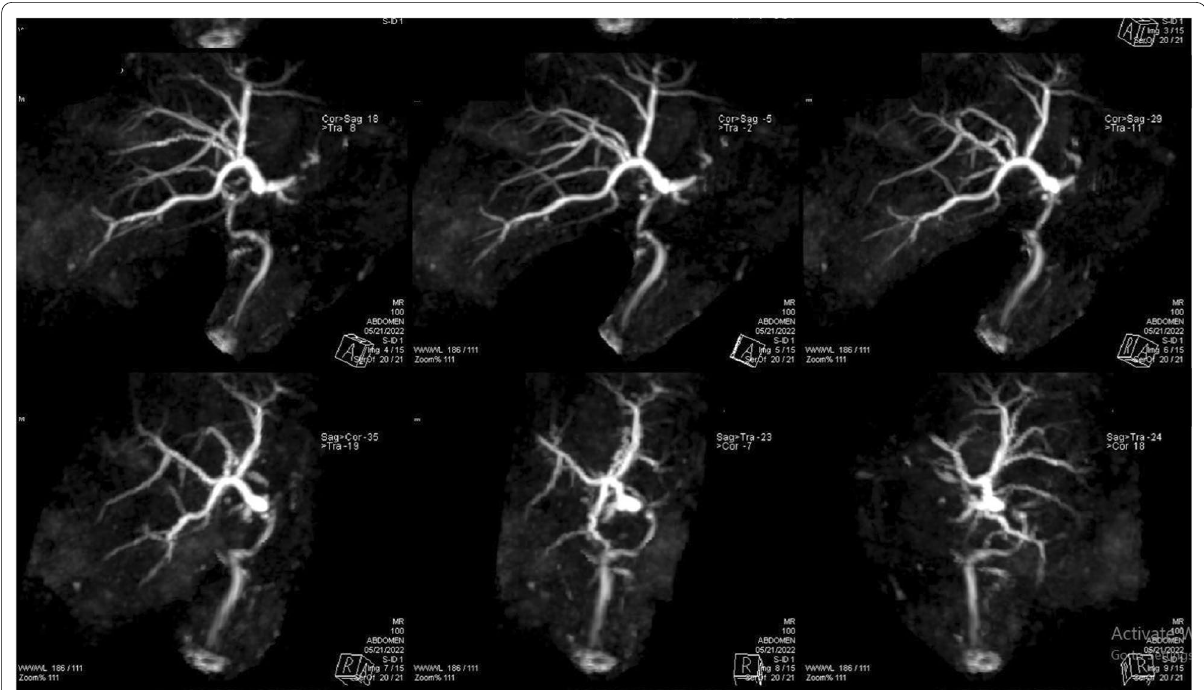
Fig. 15 MRCP images showing mild intrahepatic biliary channels dilatation with focal stricture at the site of